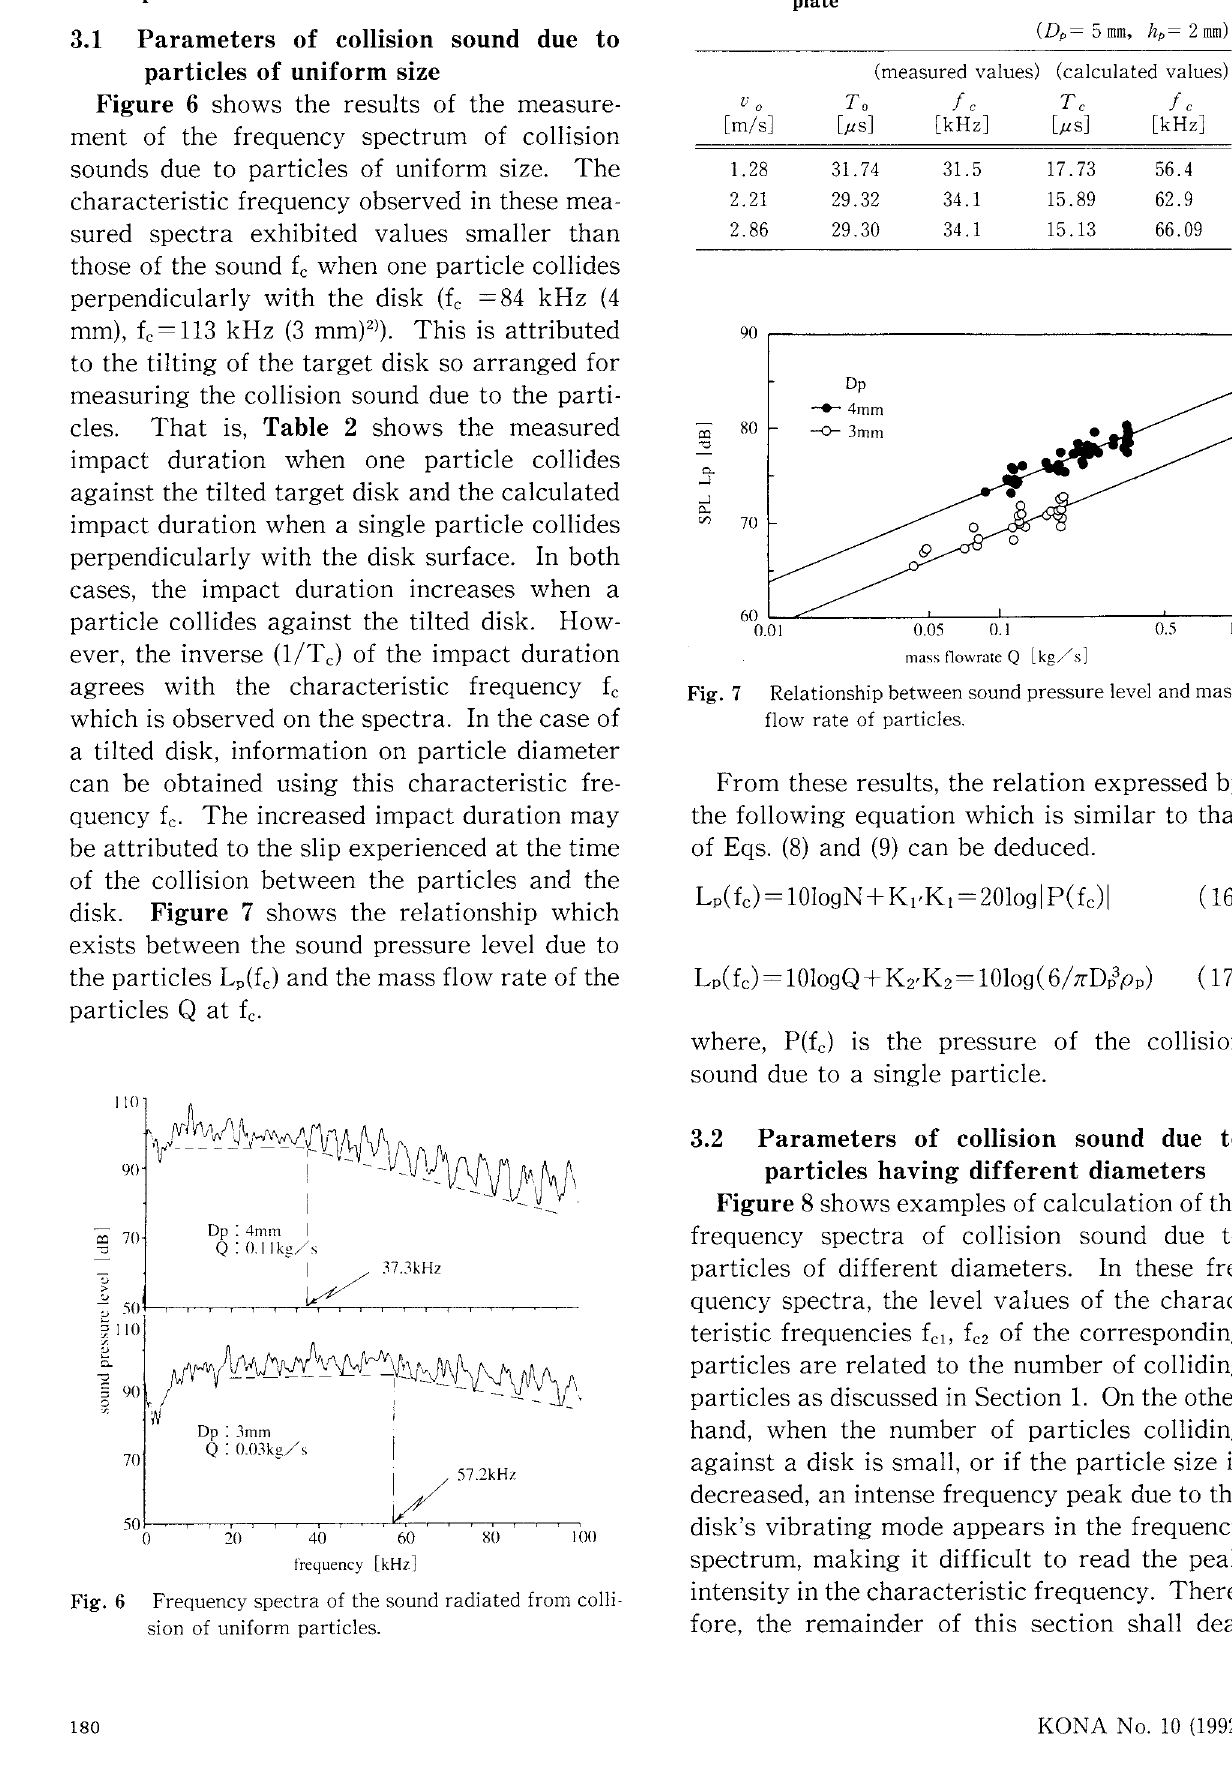
Table 2 Contact duration between a particle and inclined plate